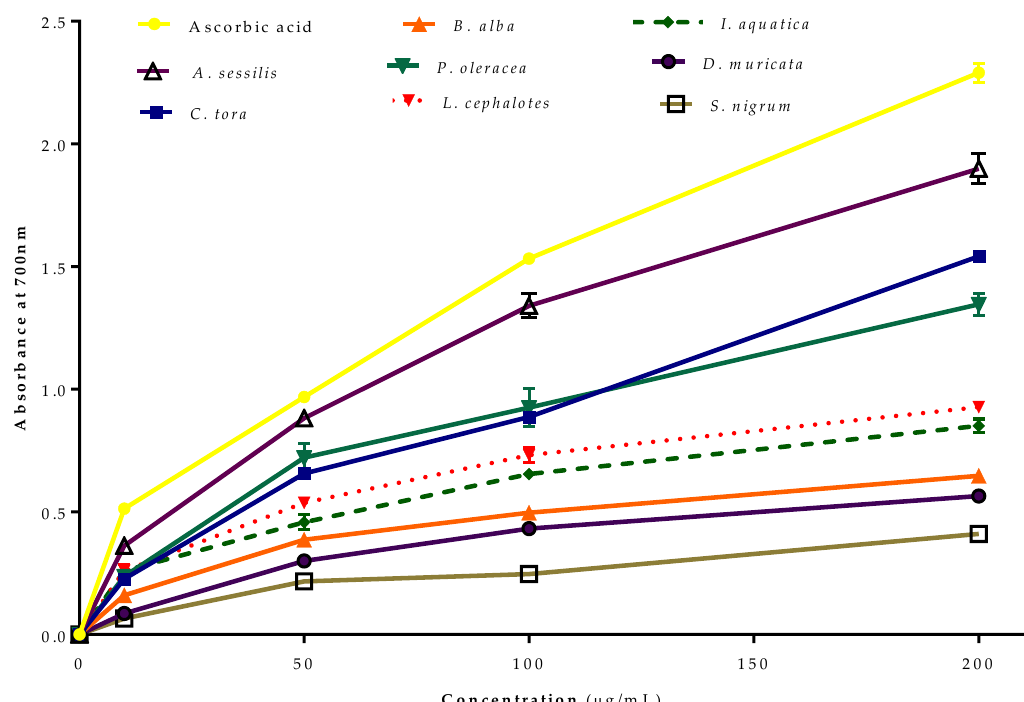
Figure 3. Ferric reducing antioxidant power (FRAP) of selected wild leafy plants. Results expressed as the mean ± standard deviation (n = 3) at concentrations of 10 – 200 µg/mL.